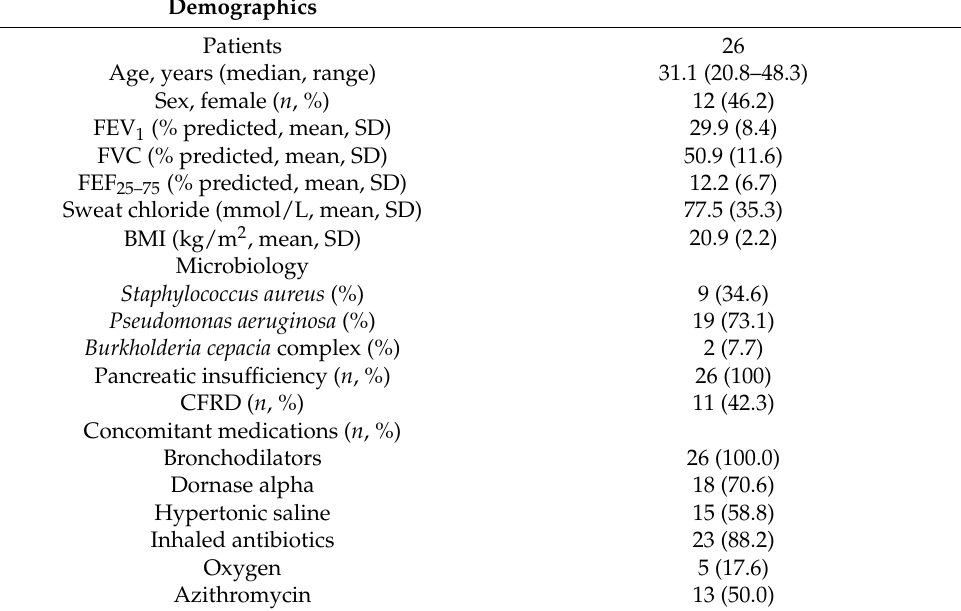
Table 1. Baseline